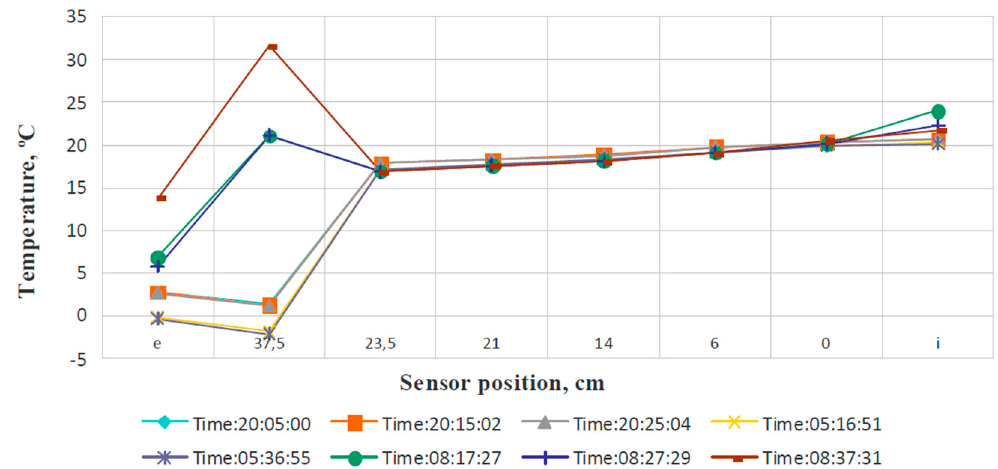
Figure 6. Temperature profiles for the selected measurement